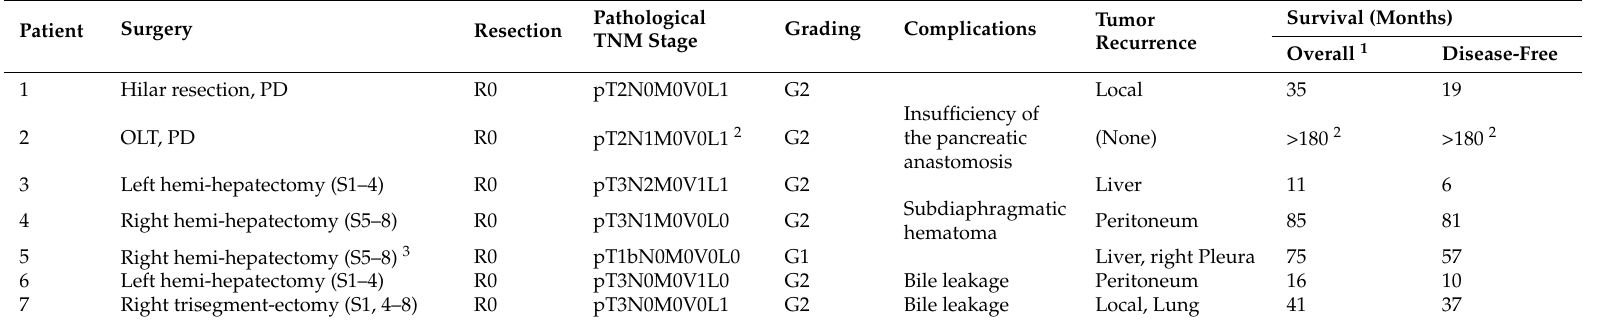
Table 2. Surgical procedures, histopathological staging and